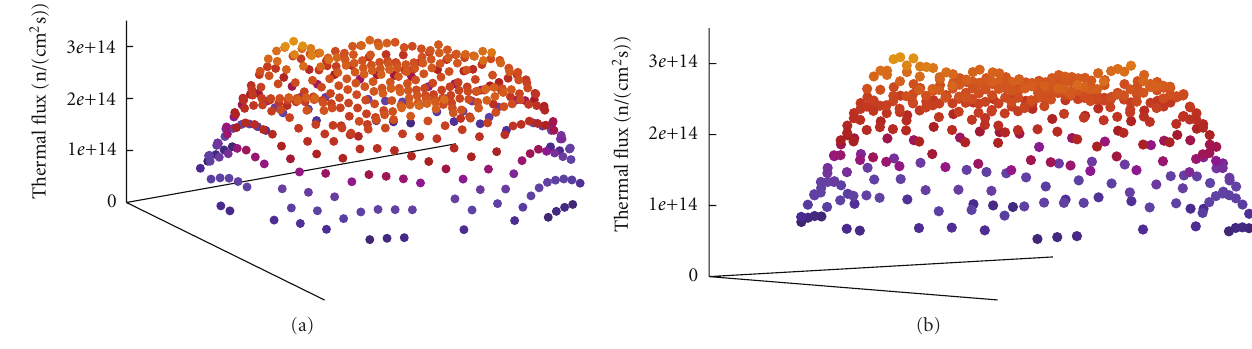
Figure 8: Instantaneous radial and azimuthal thermal neutronic flux distribution in the middle plane of the core. Each dot corresponds to an individual channel.